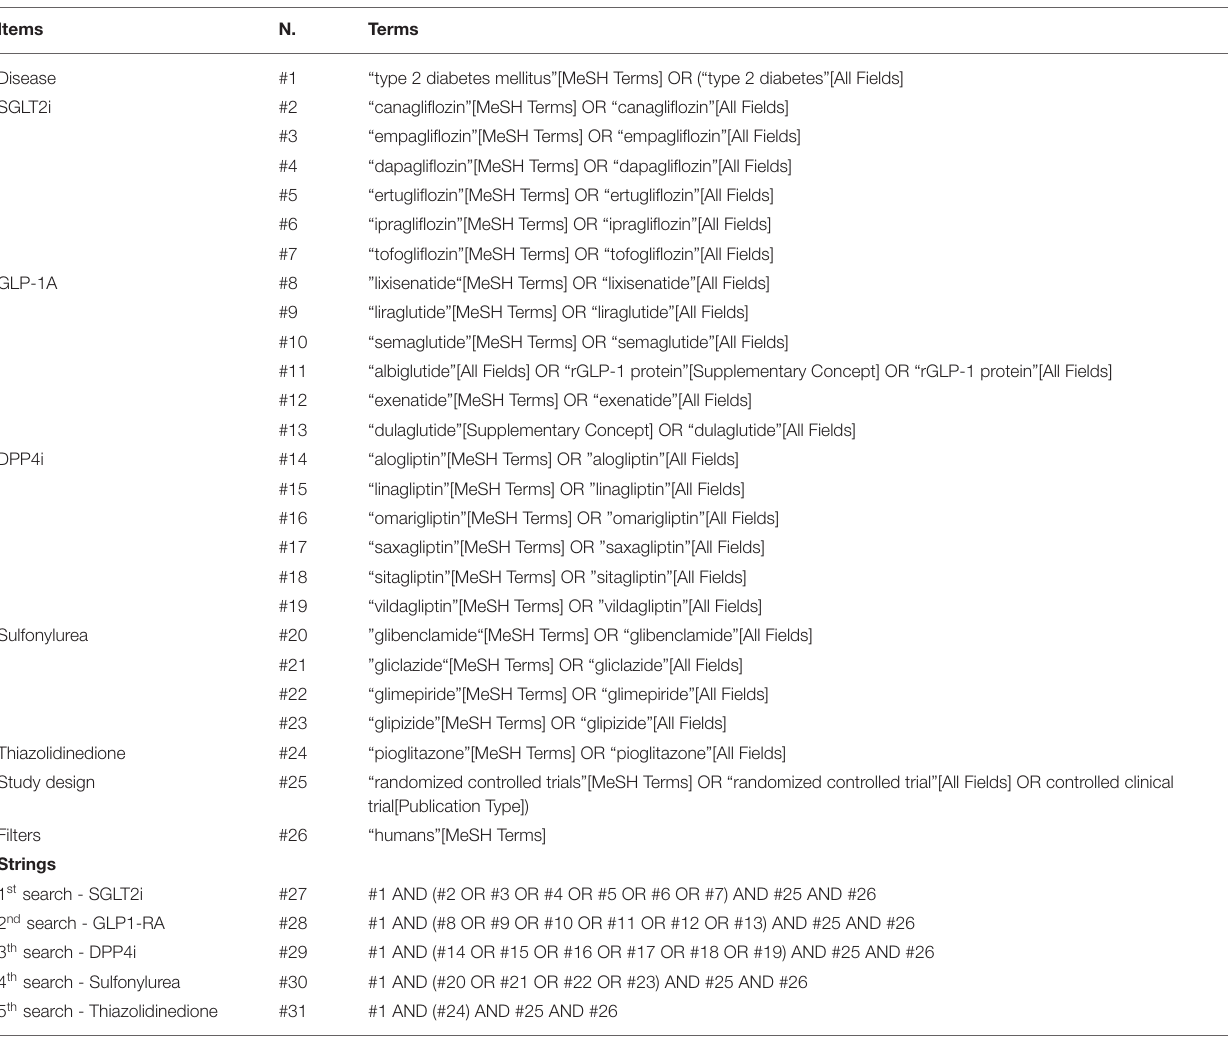
TABLE 1 | Search terms used in systematic review protocol. Items